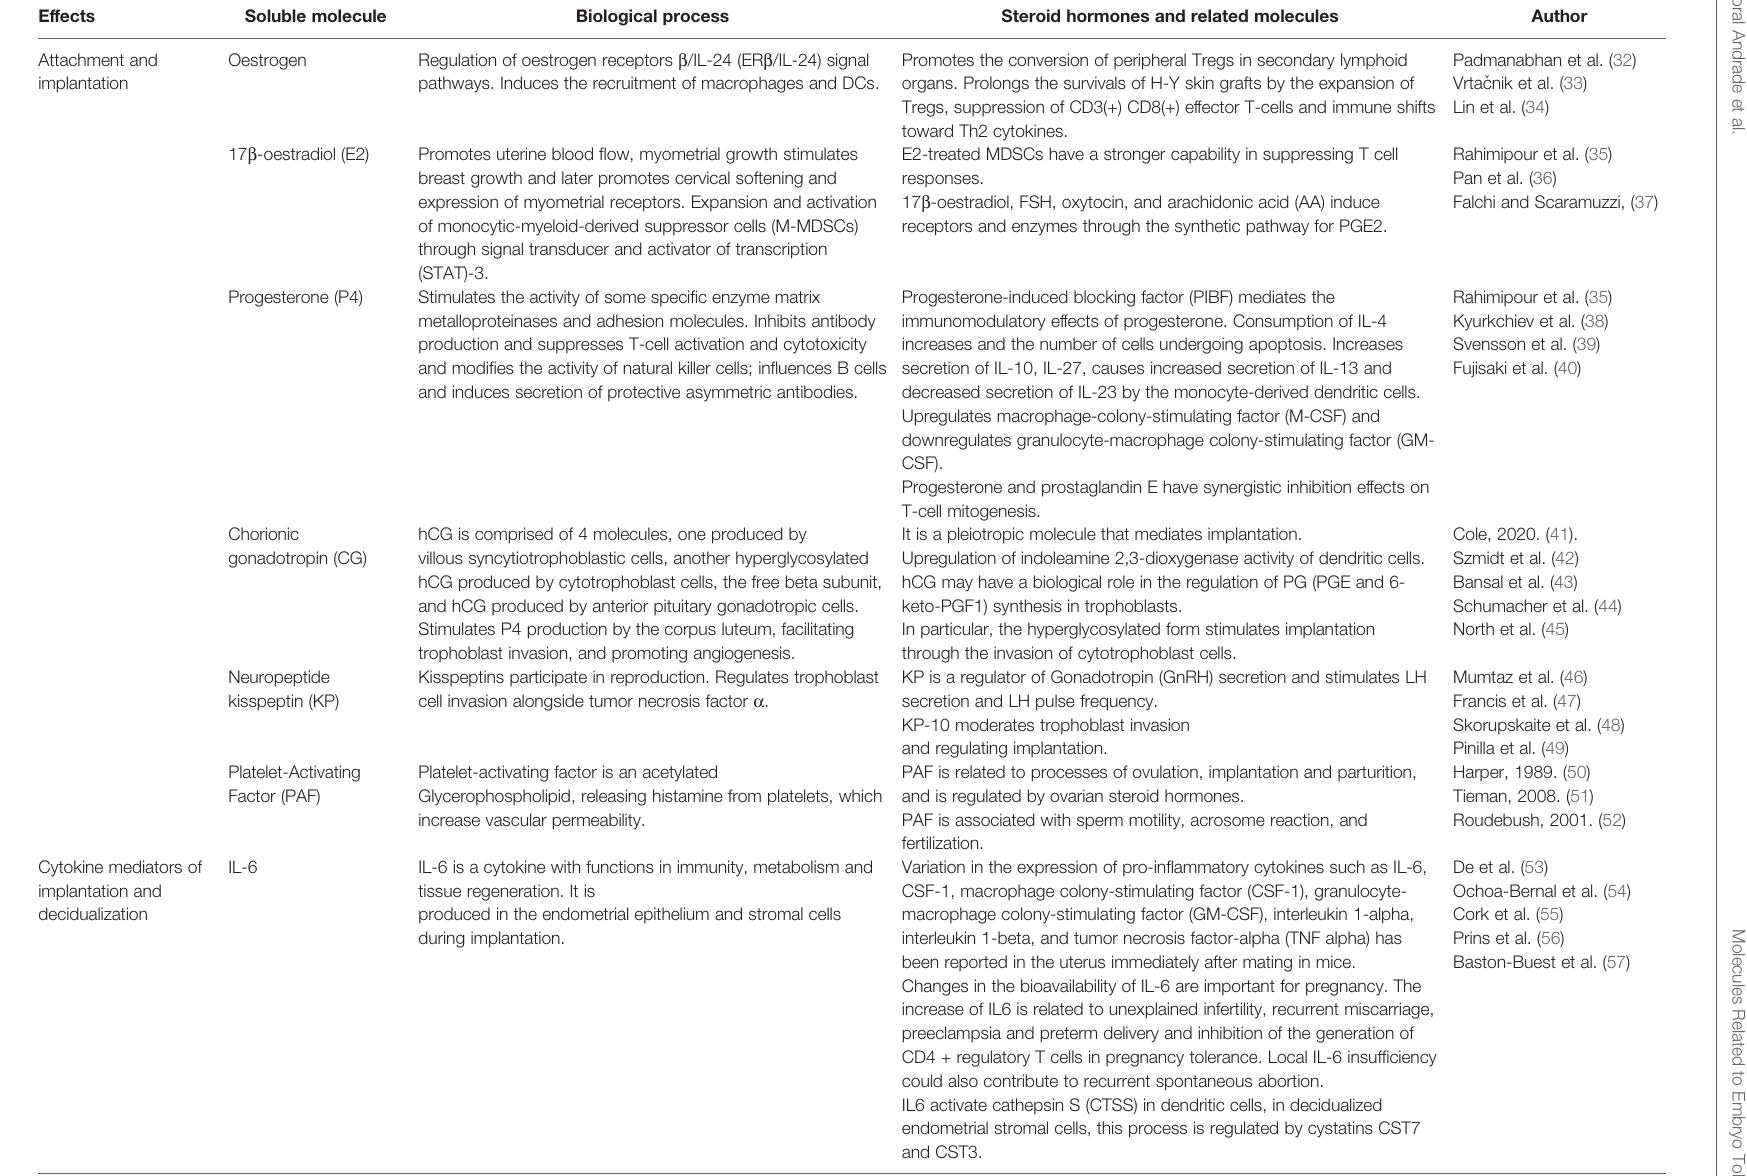
TABLE 2 | Principal soluble molecules acting in implantation (apposition/adhesion/invasion) to maintain fetal-maternal tolerance.